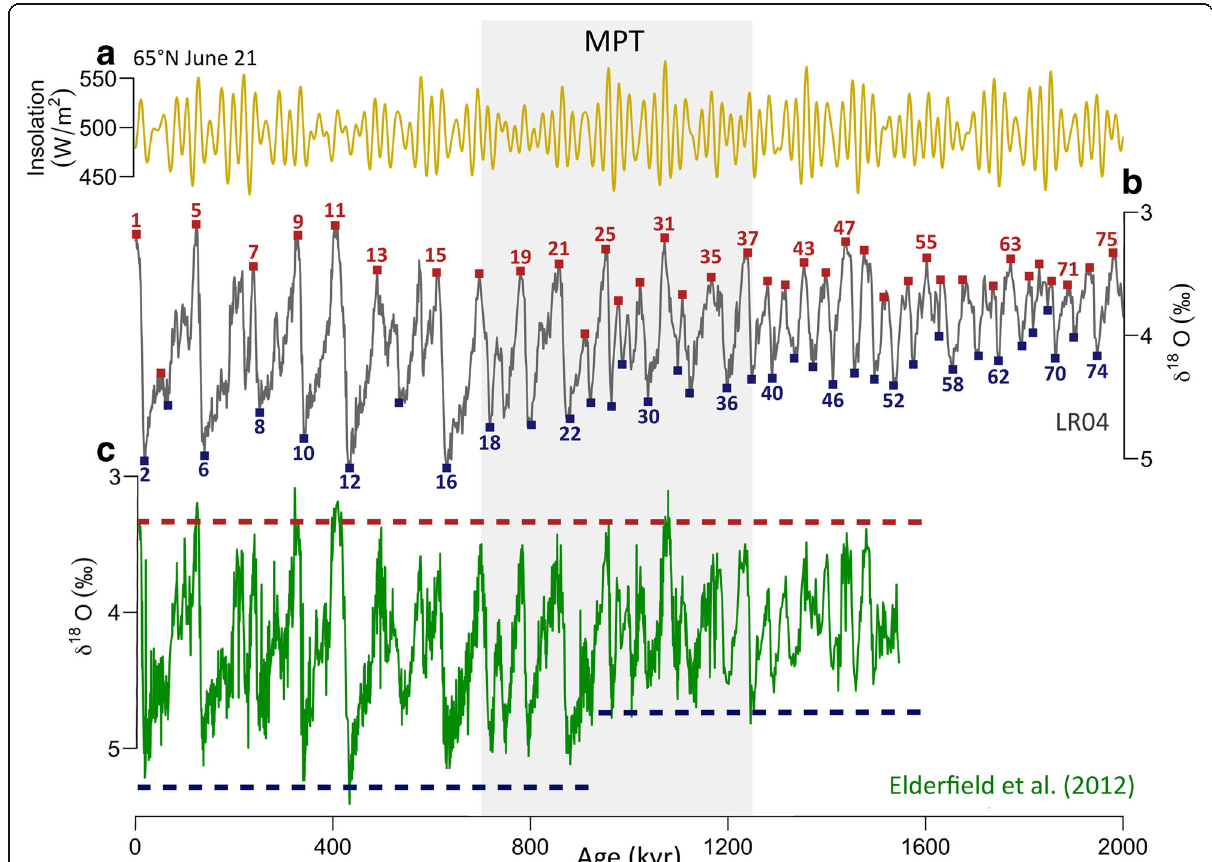
Fig. 1 Earth ’ s climate variability in the last two Myr. a 65° N 21st June insolation. b Global ice volume benthic LR04 stack (Lisiecki and Raymo 2005). c Global ice volume stack by Elderfield et al. (2012). Note the sudden increase in ice volume at stage 22 in the Mid Pleistocene Transition